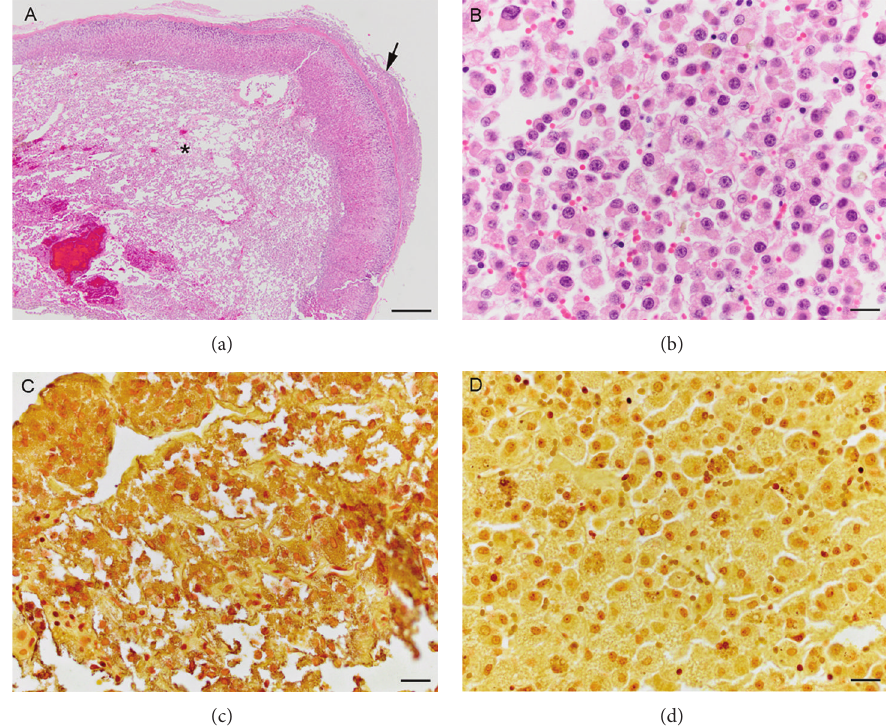
Figure 2: Adrenal gland from a rabbit. (a) The adrenal medulla is replaced by a well-demarcated mass of neoplastic cells (asterisk), which compresses the overlying adrenal cortex. There is also extracapsular adrenal cortical hyperplasia (arrow). Hematoxylin and eosin (H&E) stain. Bar = 200 𝜇 m. (b) The neoplastic cells are round to polygonal and occasionally form cords or nests, which are separated by vascular spaces. Occasionally the cytoplasm is vacuolated. H&E stain. Bar = 10 𝜇 m. (c) Compressed normal adrenal medulla with brown cytoplasmic granules. Churukian-Schenk stain. Bar = 10 𝜇 m. (d) The neoplastic cells do not contain brown cytoplasmic granules. Churukian-Schenk stain. Bar = 10 𝜇